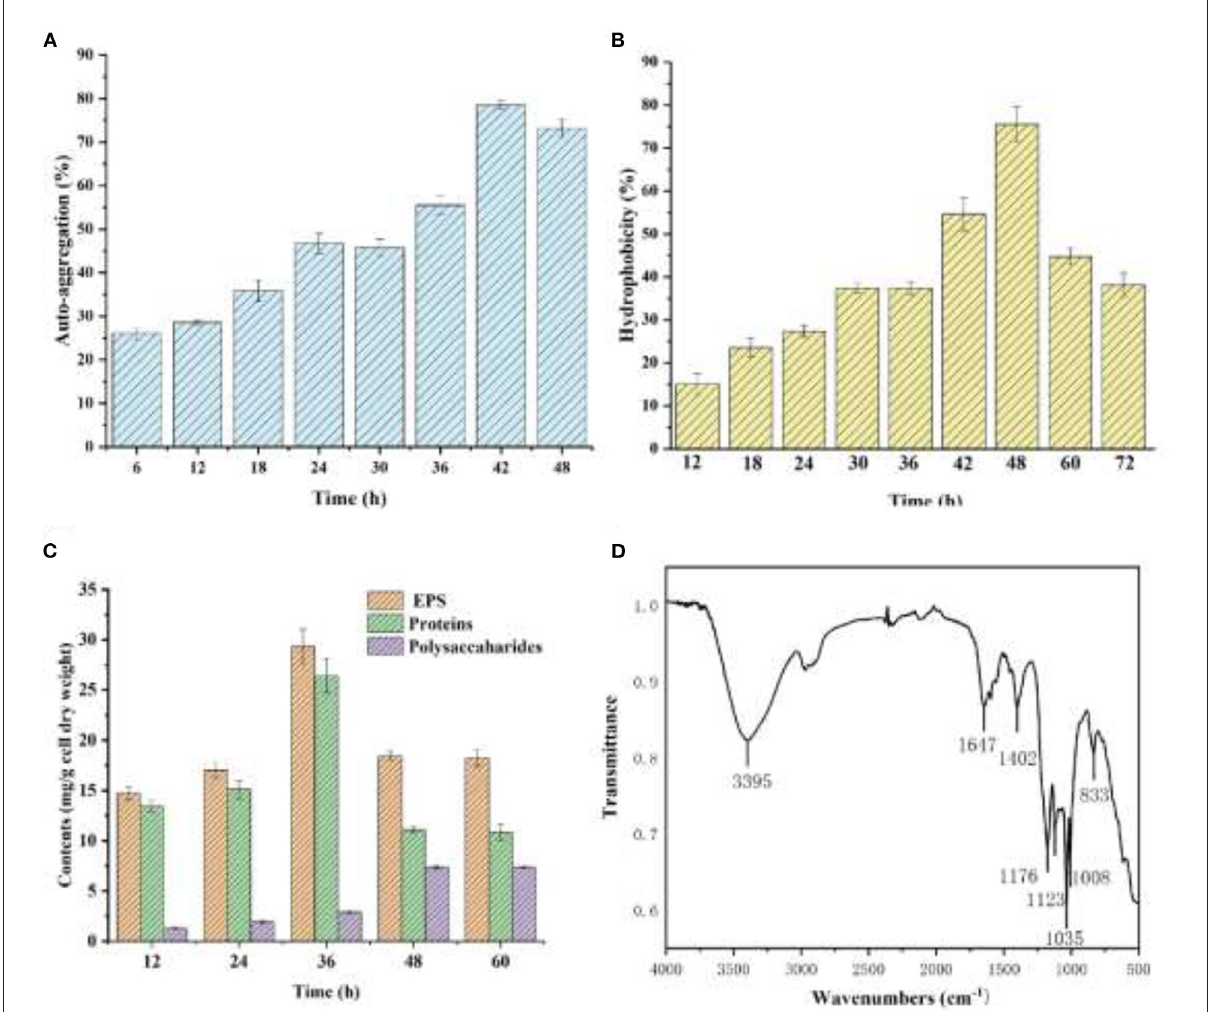
FIGURE5 Auto-aggregation index (A) and hydrophobicity index (B) of the strain YC-34, Fourier transform infrared spectra (C) and composition (D) of EPS.